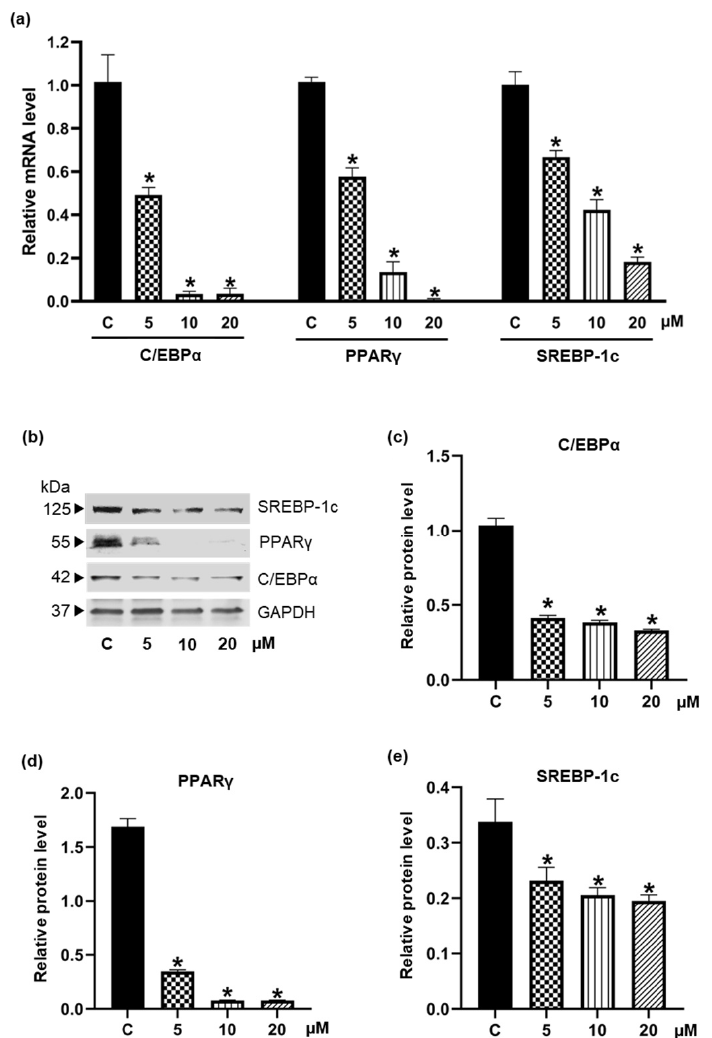
Figure 4. Effect of pinostrobin on mitotic clonal expansion in pre-adipocyte 3T3-L1 cells. Crystal violet assay was performed after 24–72 h cultured with differentiation medium with or without 5– 20 µM pinostrobin. Cell proliferation was presented relative to the vehicle control cells (C) treated with 0.5% DMSO for 24 h.